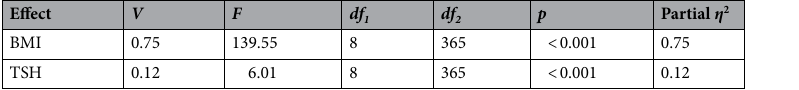
Table 1. The results of Pillai’s trace omnibus MANCOVA tests for two main effects: one factor (TSH) and one covariate (BMI). V Pillai’s trace test statistics.